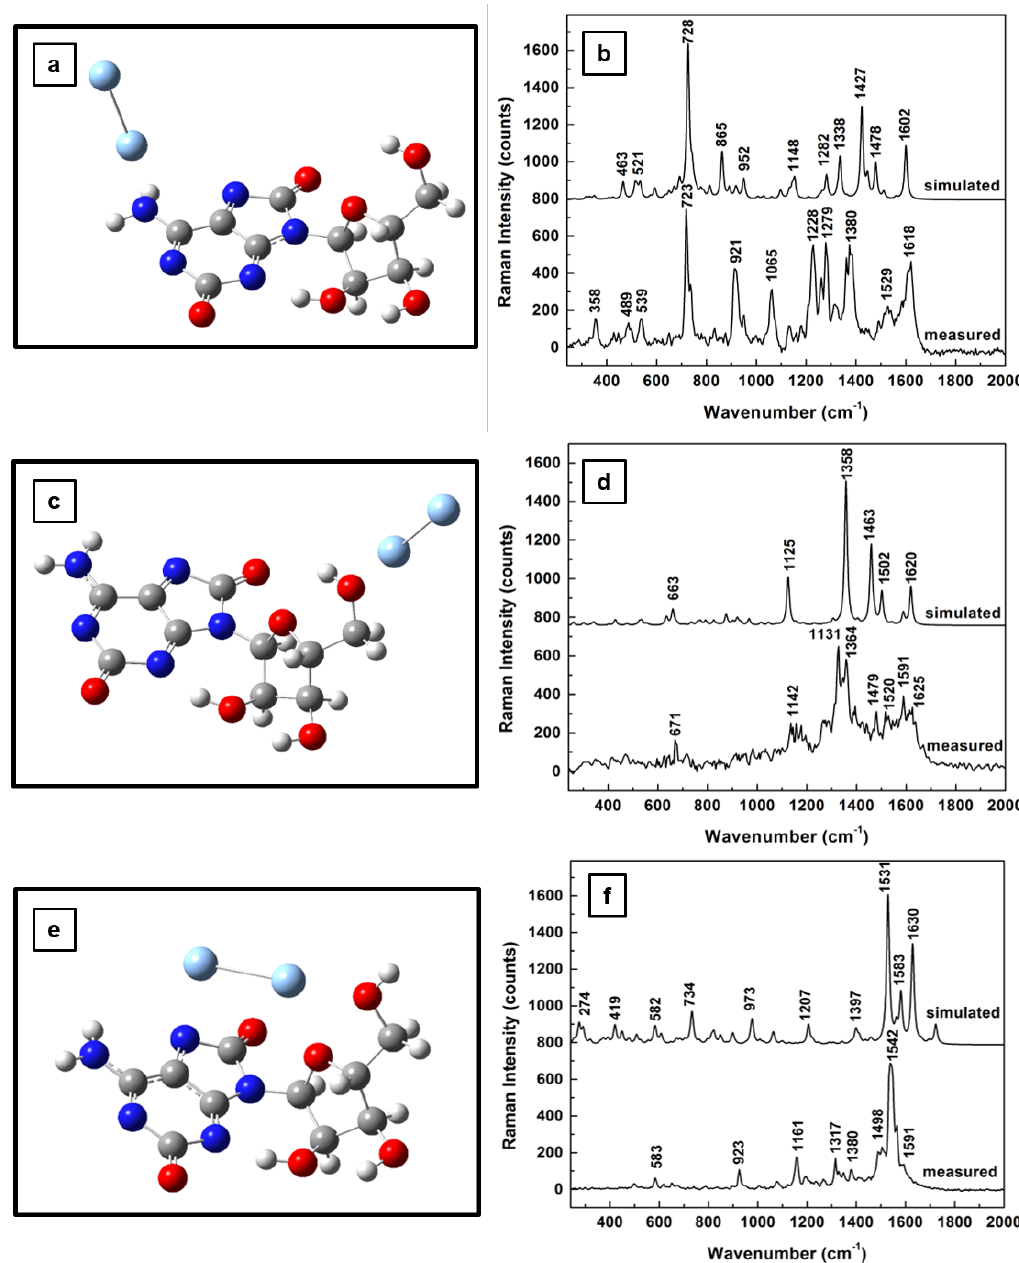
Figure 6. Structural representations of fully oxidized adenosine (the last step of the 2-electron oxidation of adenosine) in the proximity of a silver dimer: ( a ) dimer in the proximity of NH 2 site of pyrimidine ring, ( c ) dimer in the vicinity of the hydroxyl groups of the ribofuranose moiety, and ( e ) dimer between the OH and NH 2 chemical bonds of the ribose and adenine structural units, respectively. ( b , d , f ) Theoretically estimated and experimentally recorded Raman vibrational spectra associated with ( a , c , e ), respectively. The spectra are vertically translated for easier visualization and appropriately labeled .